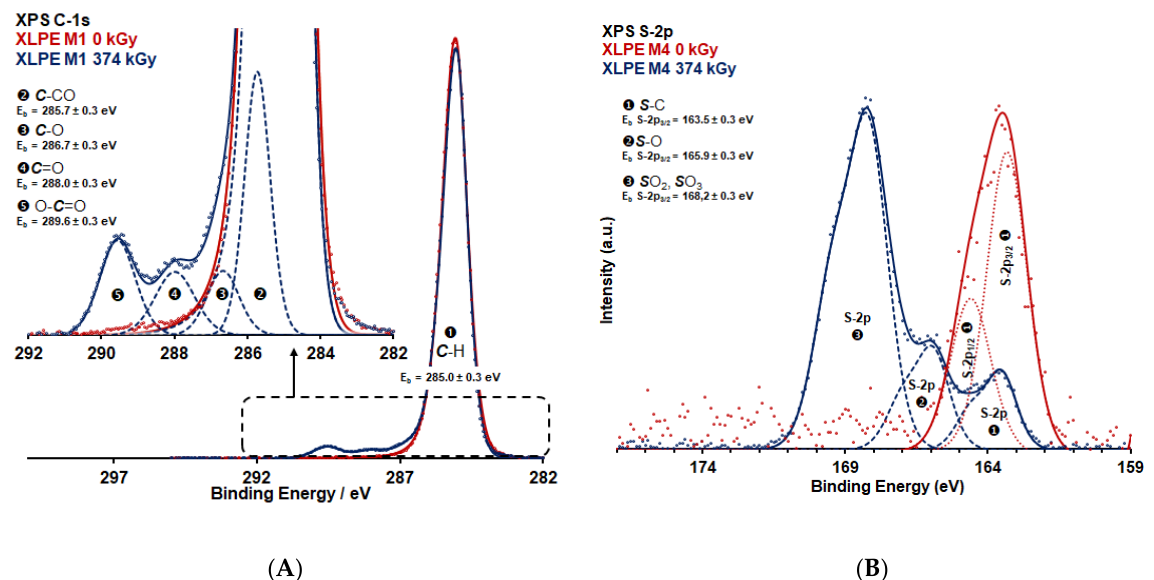
Figure 2. ( A ) XPS curve fitting spectra corresponding to C -1s spectra of XLPE M1 (non-irradiated in red and irradiated at 374 kGy at medium dose rate in blue). Five fixed contributions were used to fit the experimental spectra: (1) C -H at 285.0 ± 0.3 eV; (2) C -CO at 285.6 ± 0.3 eV; (3) C -O at 286.9 ± 0.3 eV; (4) C =O at 288.2 ± 0.3 eV; and (5) O- C =O at 289.5 ± 0.3 eV. ( B ) XPS curve fitting spectra corresponding to S -2p spectra of XLPE M4(Irg1076-IrgPS802) (non-irradiated in red and irradiated at 374 kGy at medium dose rate in blue). Three fixed contributions were employed to fit the experimental spectra: (1) C- S at 163.4.0 ± 0.3 eV; (2) S =O at 165.9 ± 0.3 eV; and (3) S O 2 and S O 3 at 188.2 ± 0.3 eV for the S-2p 3/2 level.